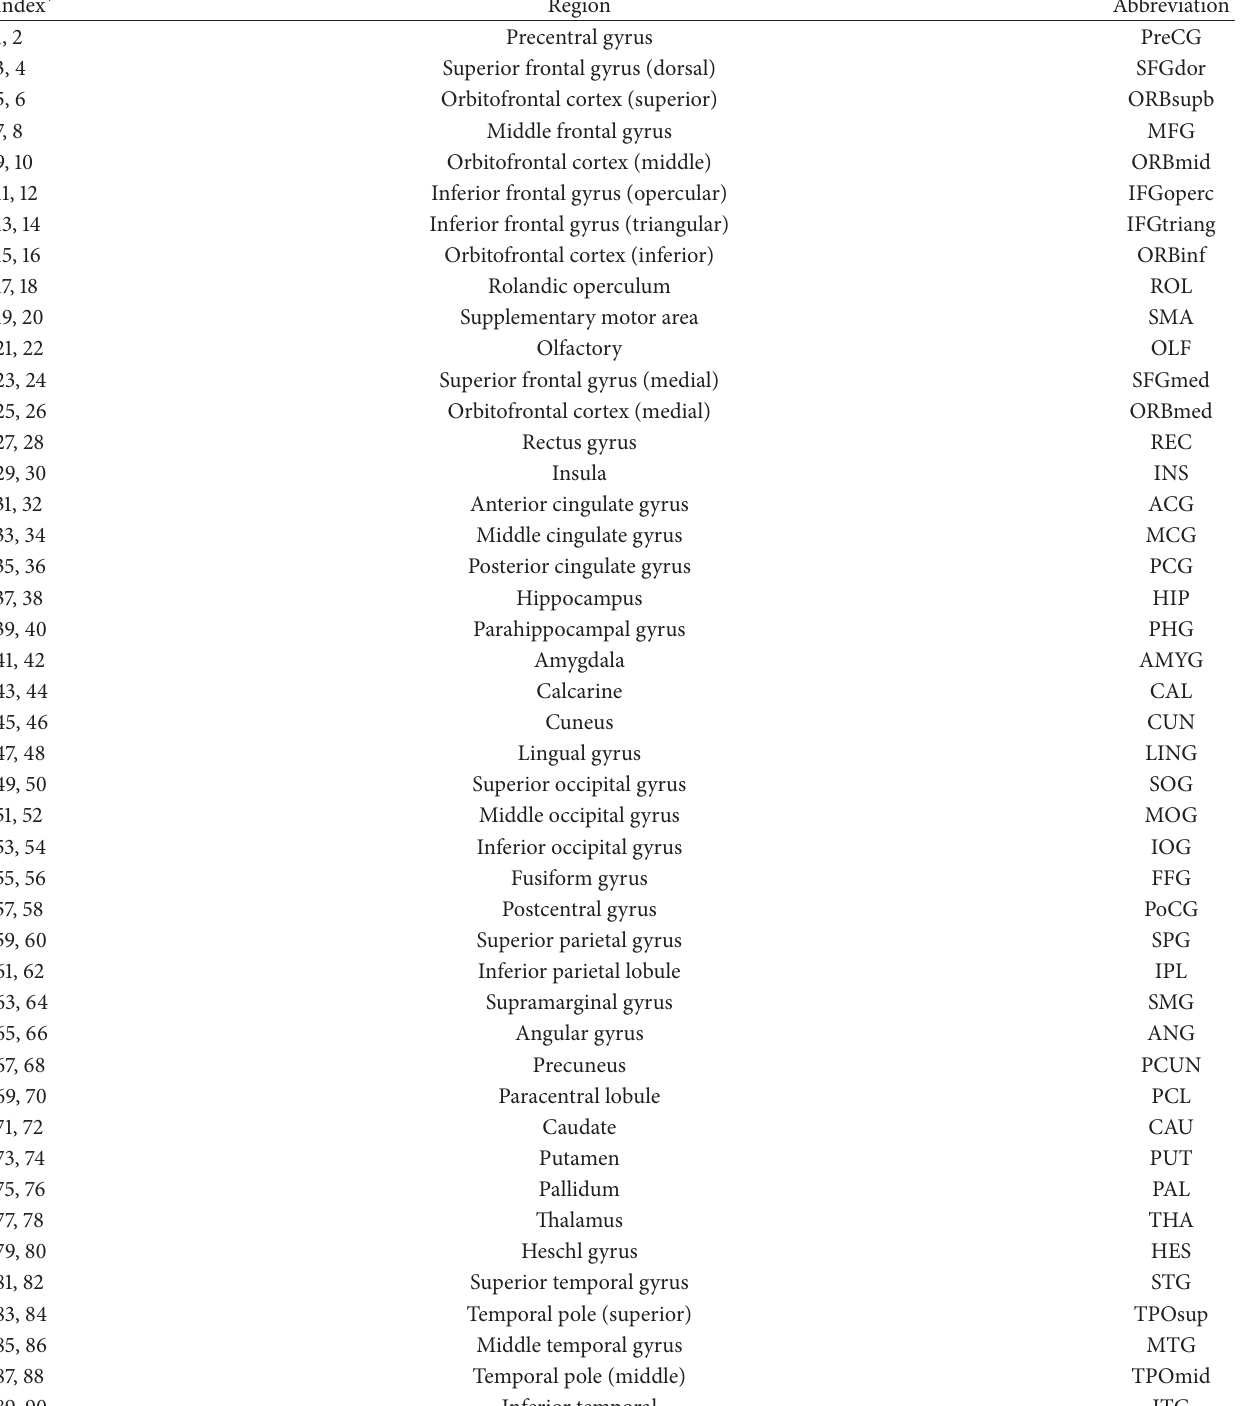
Table 2: Names and abbreviations of the 90 ROIs defined in the AAL